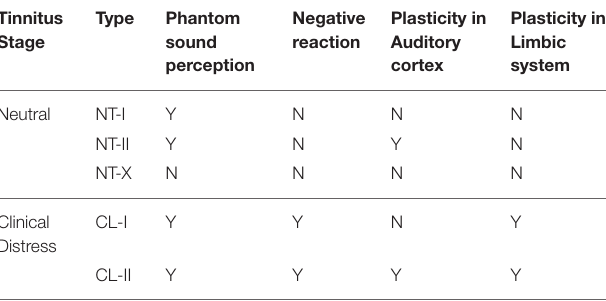
TABLE 1 | Tinnitus patient categorization accordance to the Neurofunctional Tinnitus Model development stage; Y, Yes and N, No. Tinnitus